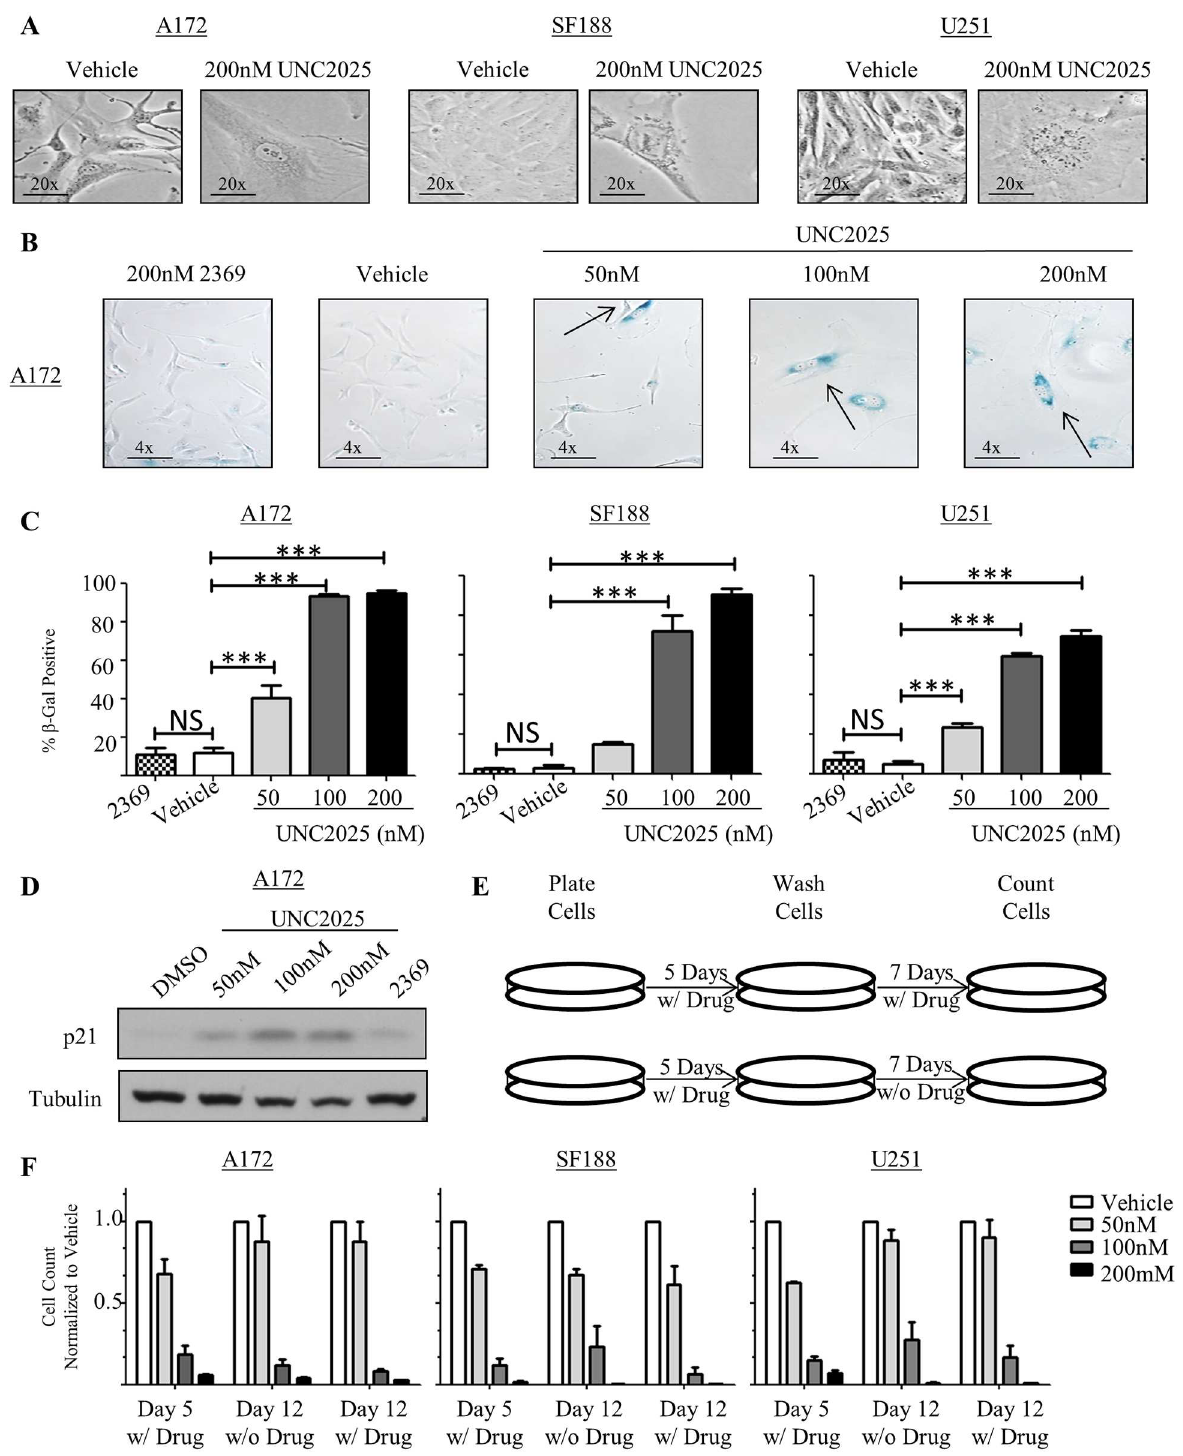
Fig 5. UNC2025 induces cellular senescence in GBM cells. A172, SF188, and U251 cells were treated with the indicated concentrations of UNC2025, UNC2369control TKI (200nM), or vehicle (DMSO). (A) GBM cells treated with UNC2025exhibit an altered morphology compared to vehicle (DMSO) treated cells. Representative images from three independent experiments are shown. (B-C) Cells were treated for five days, then fixed and stained to determine beta-galactosidase activity (blue staining = positive). Representative images of the A172 cell line (B) and mean values and standard errors derived from four independent experiments for